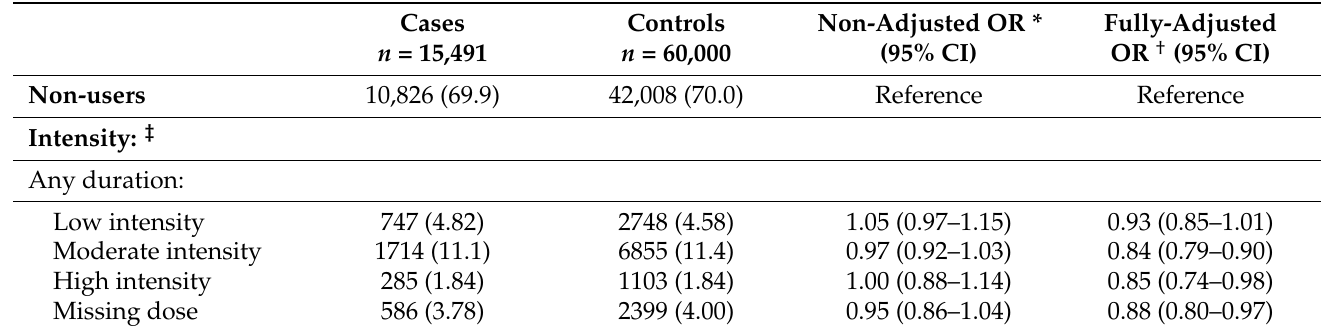
Table 4. Current use of statins and risk of colorectal cancer, by intensity and